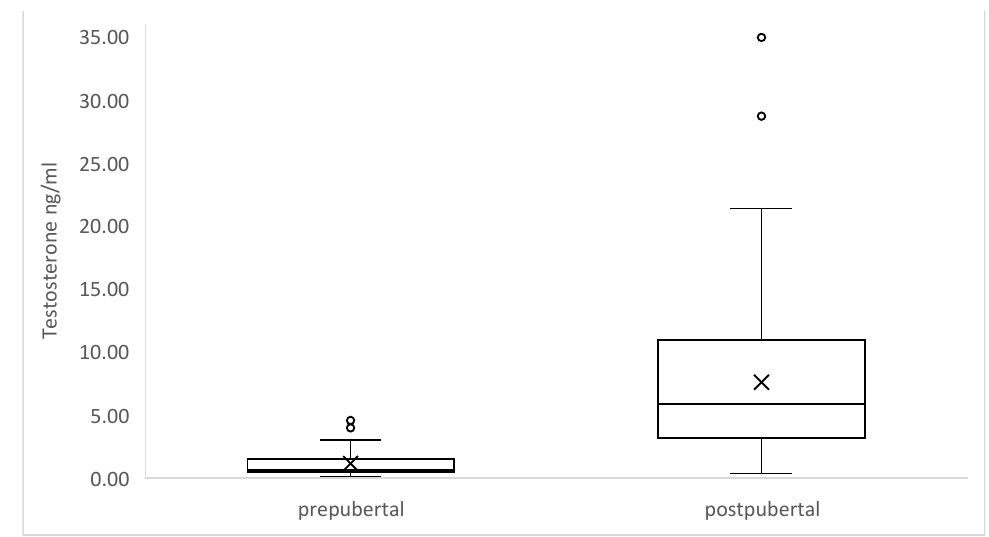
Figure 2. Prepubertal wild boars showed significantly lower T concentrations than postpubertal. The latter presented a wider range of values in comparison to prepubertal ones.